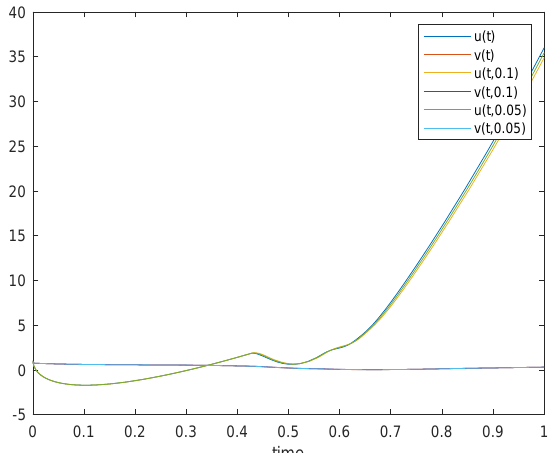
Figure 5. Example 2 numerical simulation of the UH-stability of the solutions with ε =